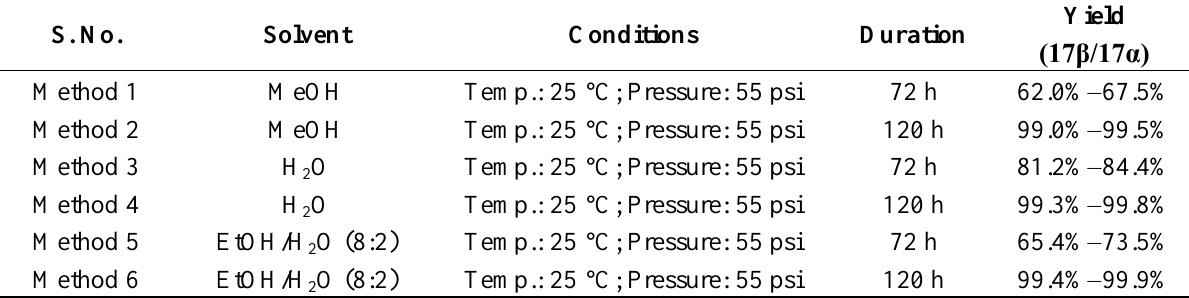
Table 6. Catalytic hydrogenation of Rebaudioside A ( 1 ); Rebaudioside B ( 2 ); Rebaudioside C ( 3 ); and Rebaudioside D ( 4 ) using Pd(OH) S.